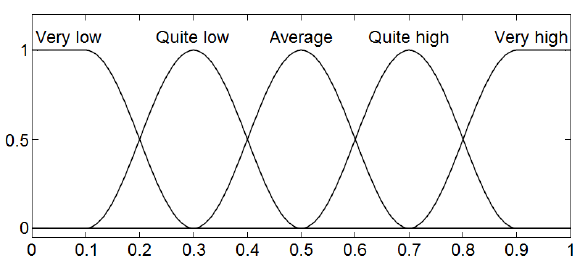
Figure 3: Membership function for the input variable x 1 – PR(Uph) , harmonic functions